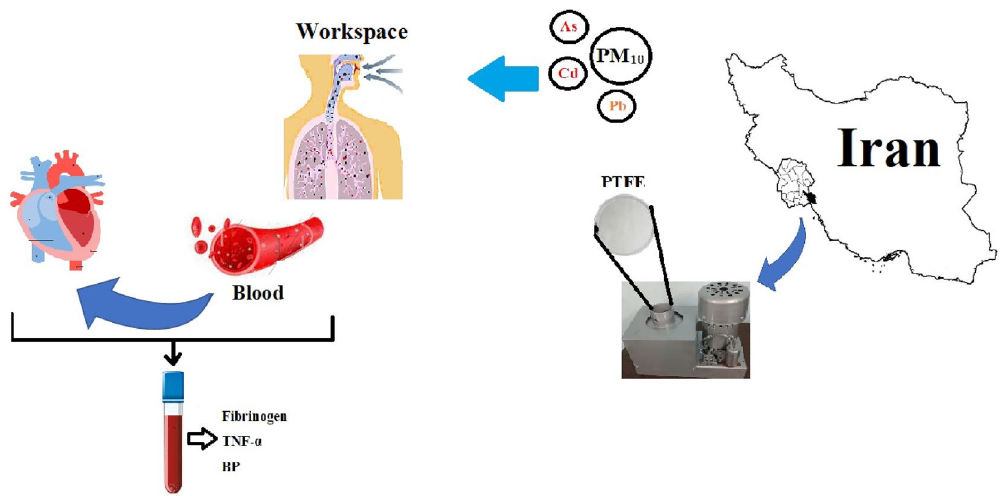
Figure 1. Schematic summarize of this Study and the its